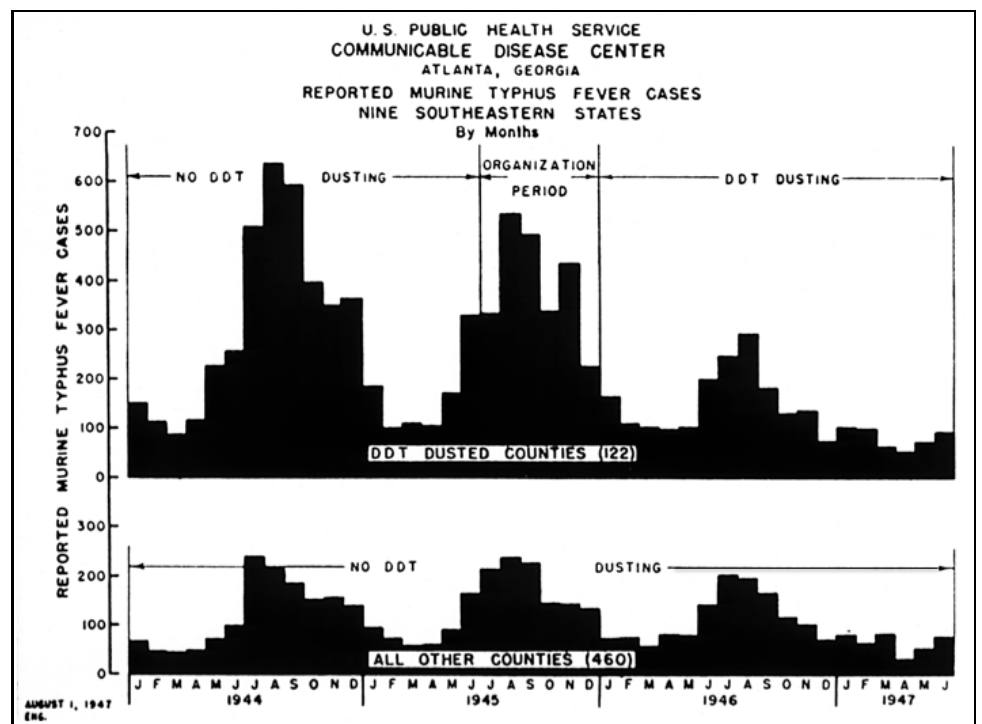
Figure 3. A graph showing the number of cases of flea-borne typhus in nine Southern states over time in areas treated (above) and untreated (below), showing the decrease in the treated areas, as compared to the untreated areas [28].